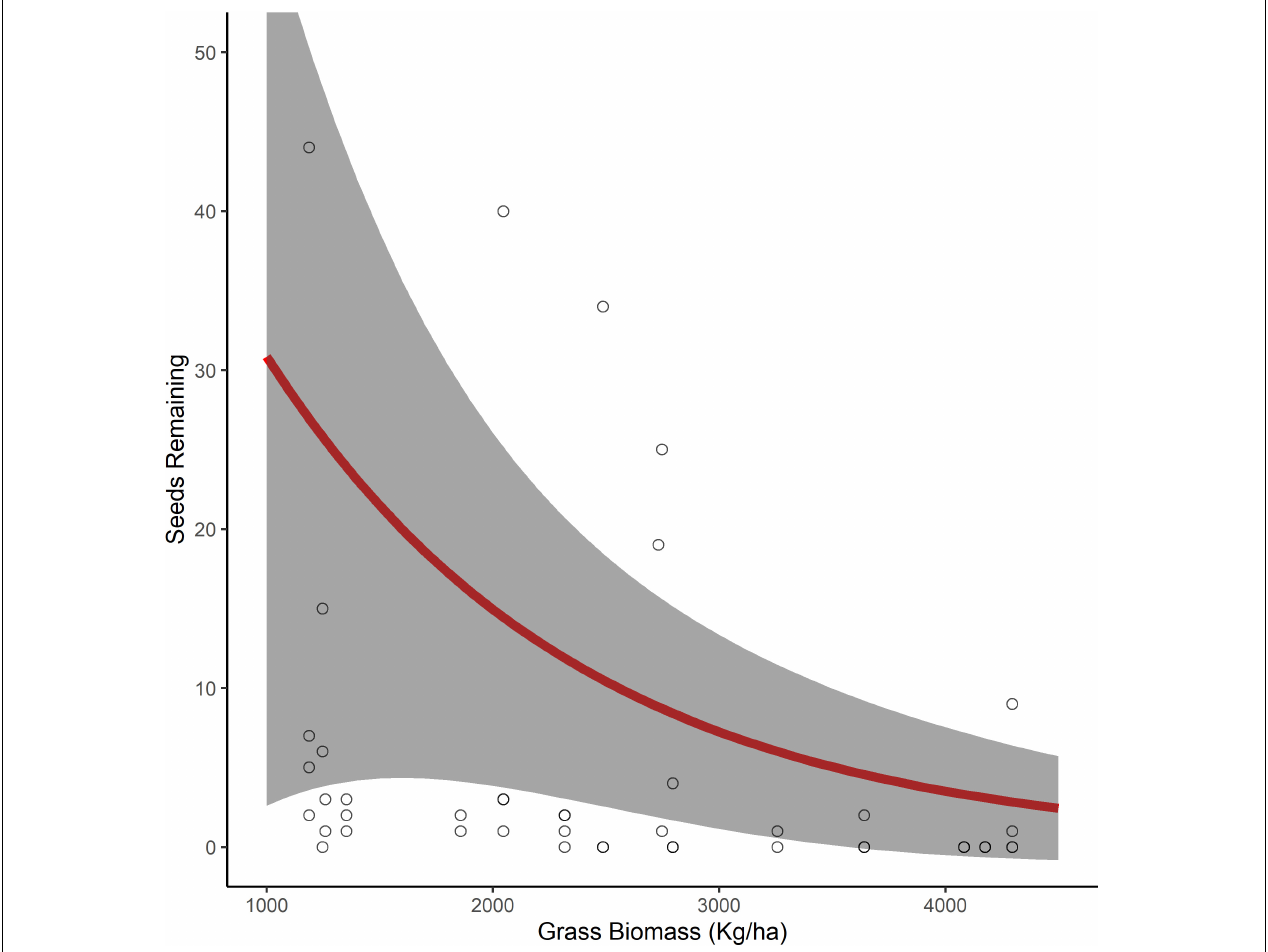
FIGURE 2 | The predicted number of Dichrostachys cinerea seeds remaining in seed trays (95% confidence interval in gray) as a function of grass biomass (kg/ha) in the surrounding environment (0.25